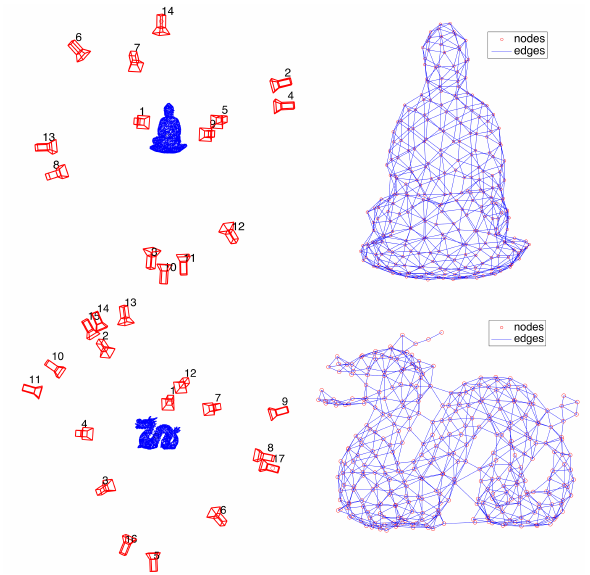
Figure 4. Sensor constellations after a finished run in DM ( ρ user = 30 , 000 ) on the left and the corresponding GNG model on the right side: result for the Buddha test object (top, k max = 14 ) and result for the Dragon test object (bottom, k max = 17 ).